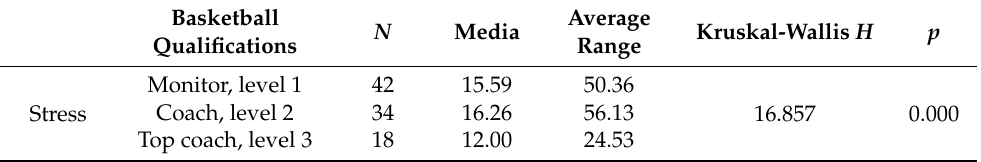
Figure A2. Comparison between pairs of the Psychological Distress in Non-Formal Contexts scale as a function of the age range variable. Table A2. Basketball qualification and Psychological Distress in Non-Formal